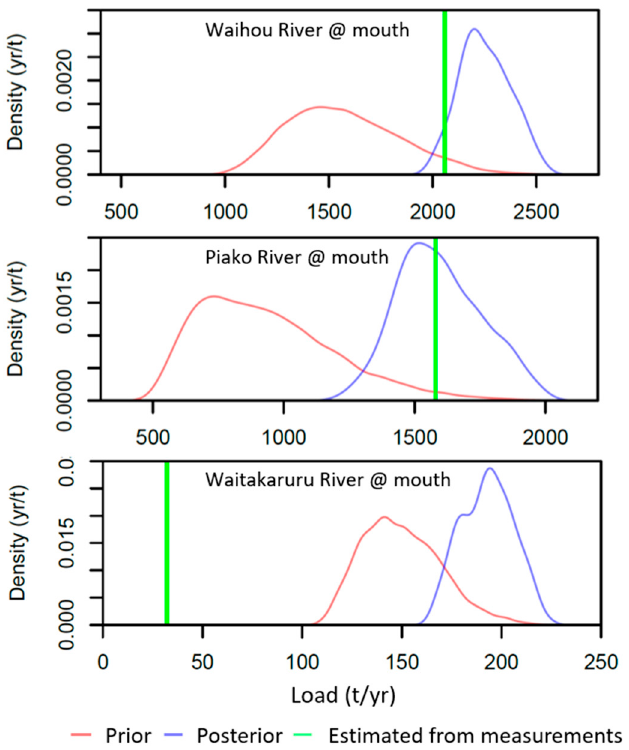
Figure 5. Example comparisons between measured and predicted loads before and after parameter conditioning. The curves are the smoothed probability density distributions of the predictions.